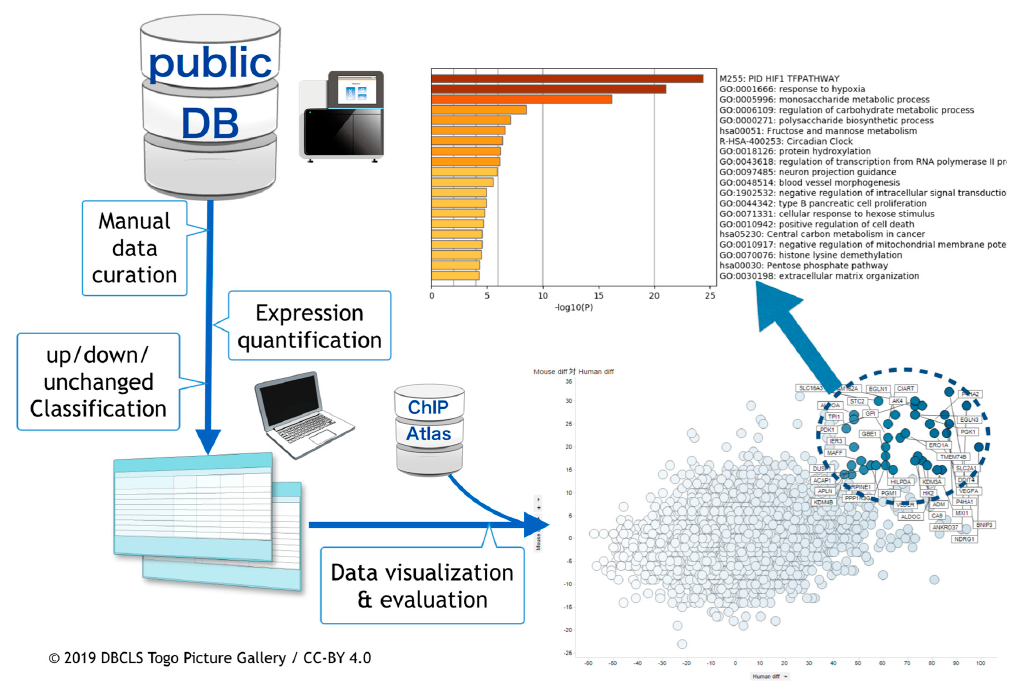
Figure 1. Schematic view of hypoxic transcriptome meta-analysis. Public databases were searched and hypoxia-related RNA-seq data were manually curated. Following this, meta-analysis was done. In conjunction with meta-analyzed data from ChIP-Atlas, data were visualized and